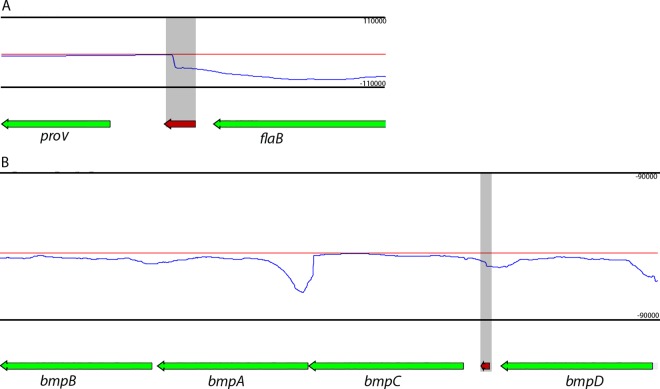
Examples of Rho-independent termination sites at the end of genes that were bioinformatically predicted and supported by transcriptomic data.(A)
flaB; and (B)
bmpDCAB. Thin red lines indicate transcript abundance from the + strand (left to right) and thin blue indicate transcript abundance from the–strand (right to left), and are shown above (+) and below (-) the central axis. Genes are noted below coverage plots and directionality is indicated by arrows at the ends of genes. Relative orientation of genes on the X axis is consistent with RefSeq annotations. Coverage per base is given on the Y axis to the left of the plot. Predicted Rho-independent terminators are indicated by red boxes on the same plane as the gene annotations and directionality is indicated by arrows. Terminators and the associated coverage at their location are highlighted by grey boxes.